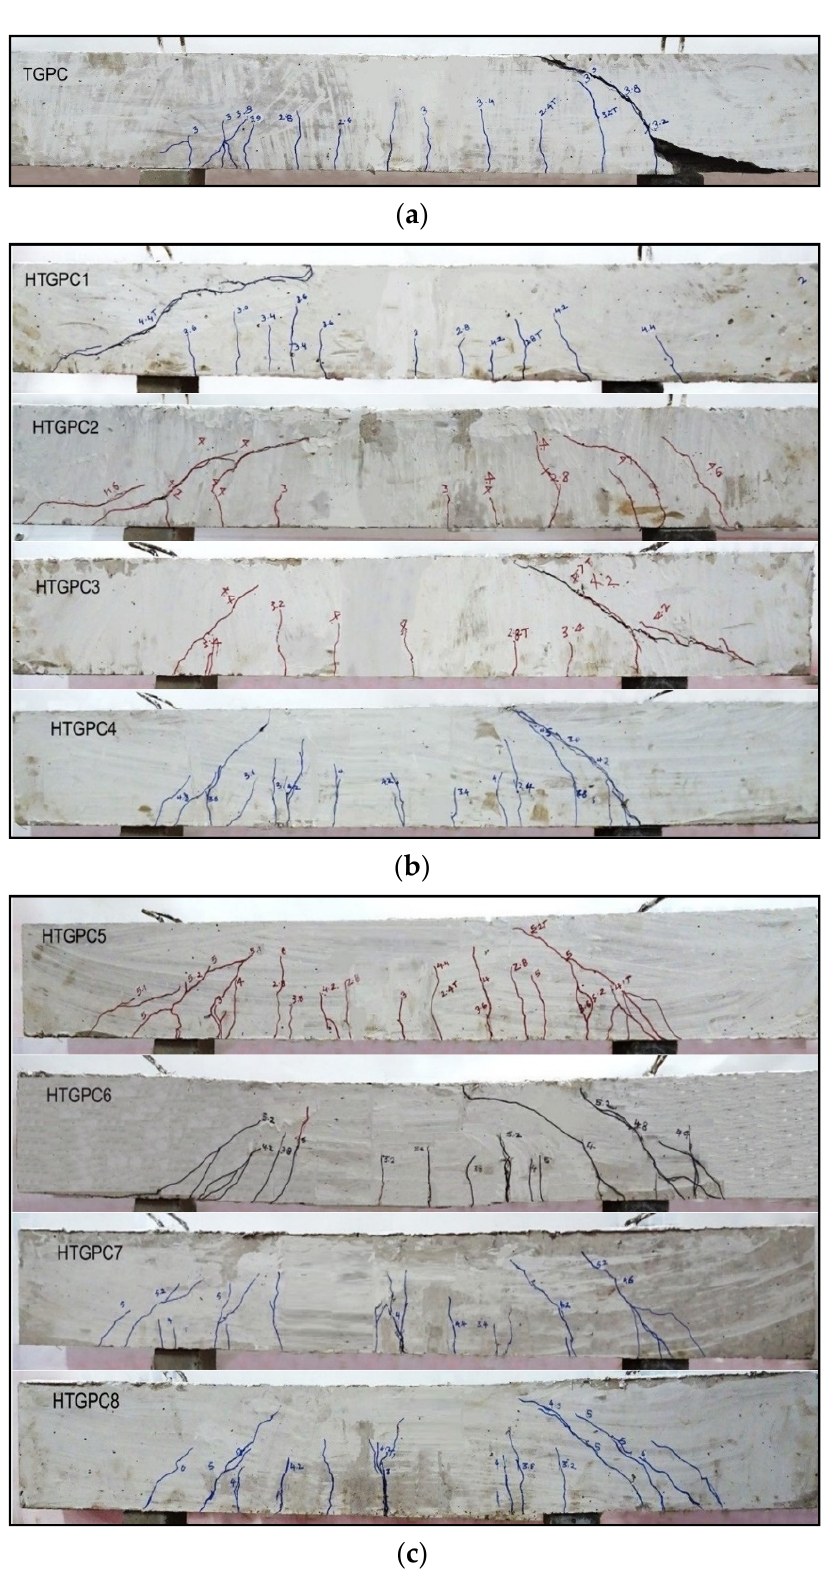
Figure 5. Crack pattern of typical tested beams: ( a ) TGPC beam; ( b ) HTGPC beams with 0.5% steel fibres; ( c ) HTGPC beams with 1% steel fibres.